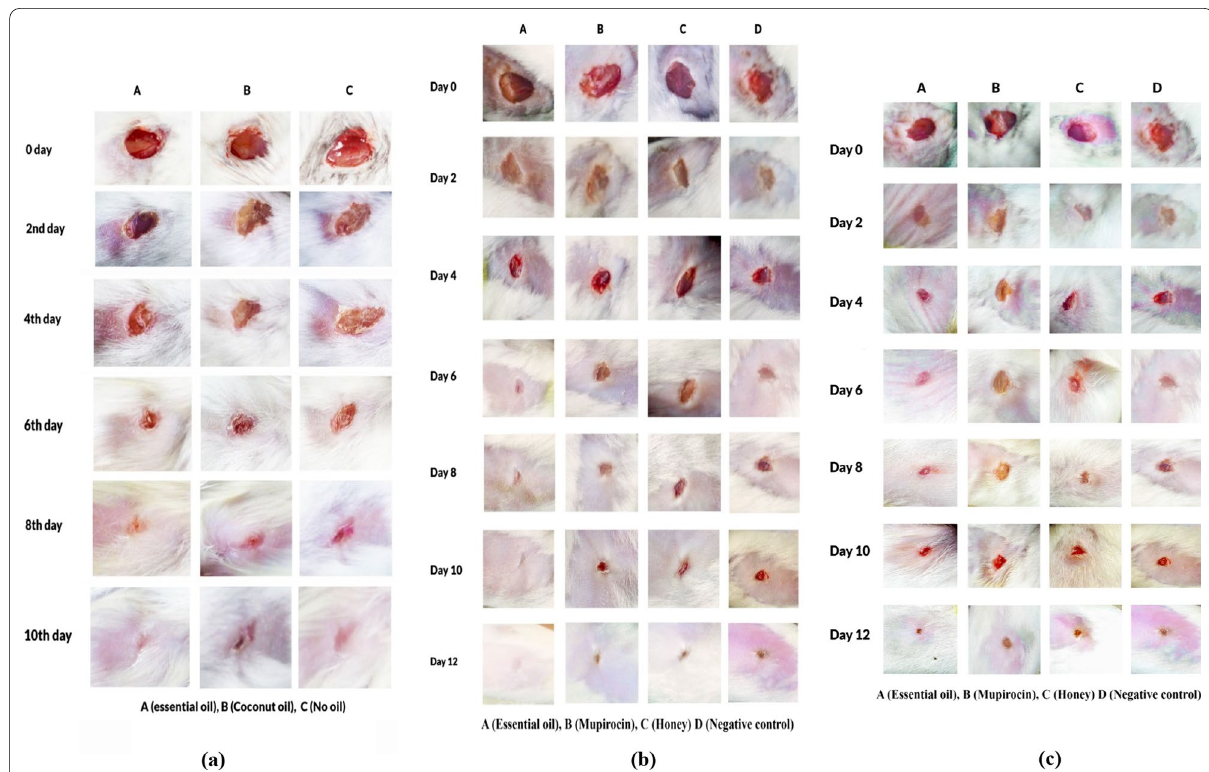
Fig. 3 Macroscopic view of the wounds during healing process a Ist set of mice (n